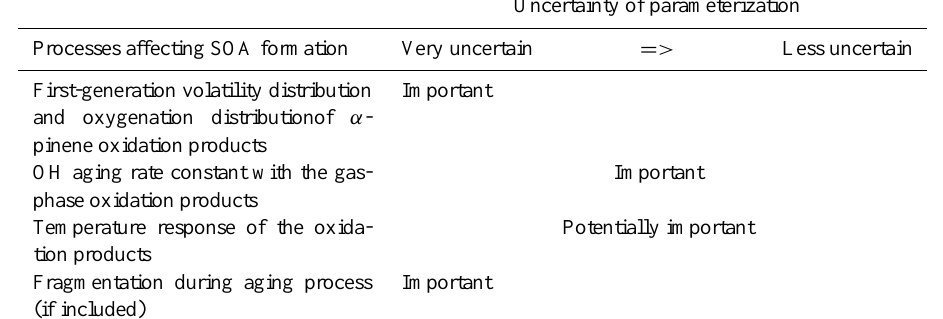
Table 4. Importance of processes that affect particle mass concentration when modeling long-term aging of biogenic SOA in the atmosphere. The uncertainties of the processes are mostly based on results from this study, where processes placed to the left are the most uncertain.